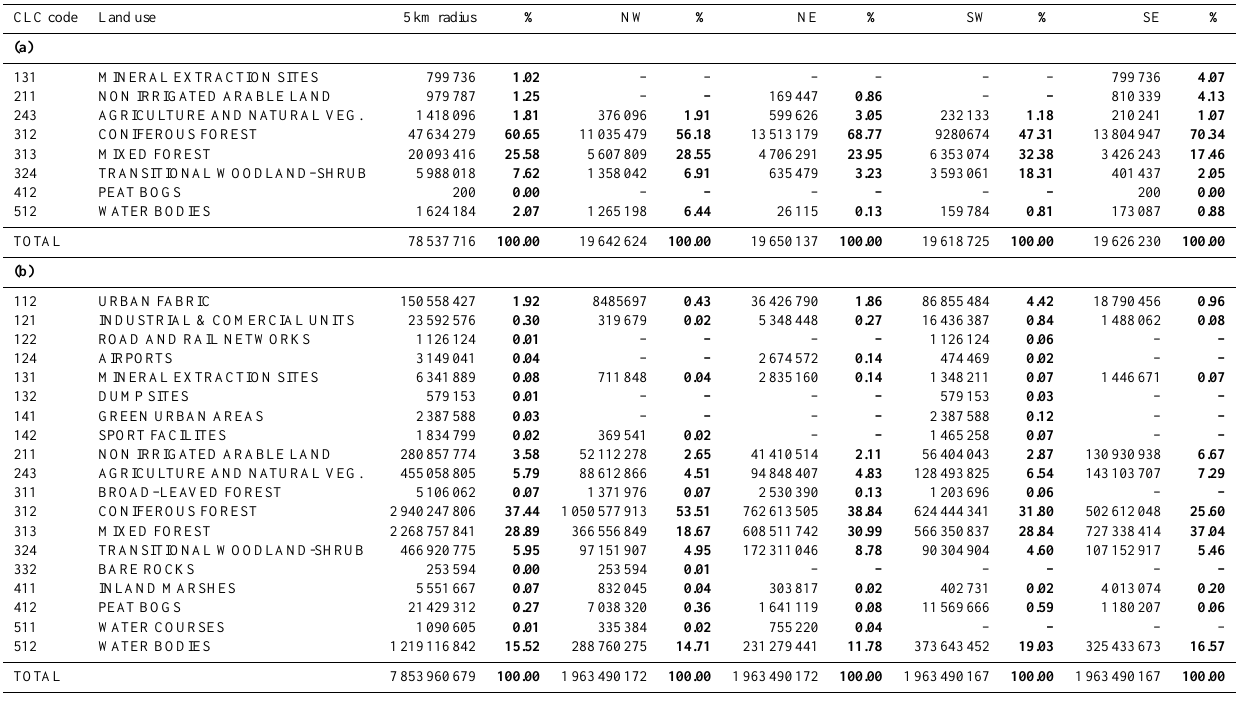
Table 4. Land use within (a) 50km and (b) 5km of the Hyyti¨al¨a site expressed in areas of activity/vegetation (m 2 ) , extracted from the European Corine landcover database 2006, defined in GIS nomenclature for types with significant coverage.